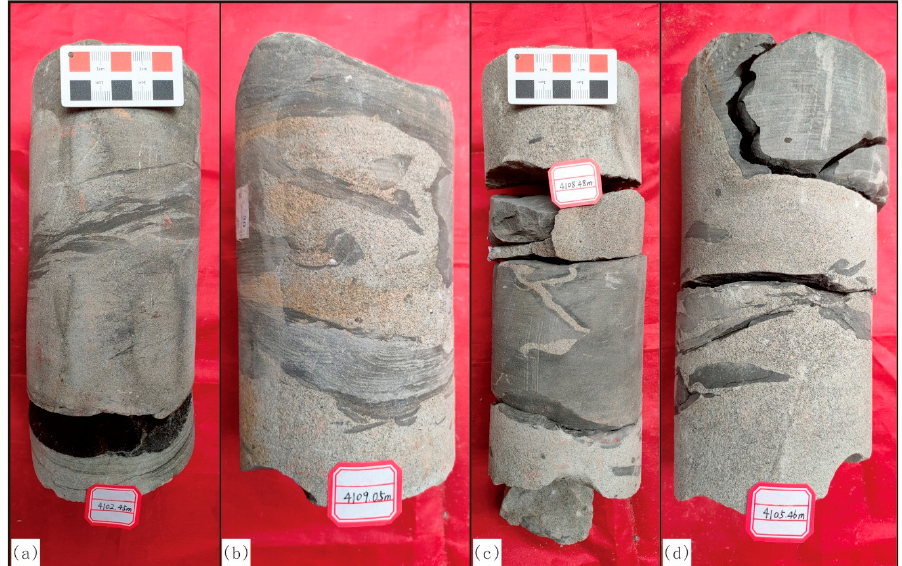
Figure 4. Typical sedimentary structure of the lower part microfacies of the single sandy debris flow deposition cycle. ( a ) Well QS7, 4102.45 m, slump deformation structure; ( b ) Well QS7, 4109.05 m, slump deformation structure; ( c ) Well QS7, 4108.48 m, scour surface structure; ( d ) Well QS7, 4105.45 m, large mud gravel.